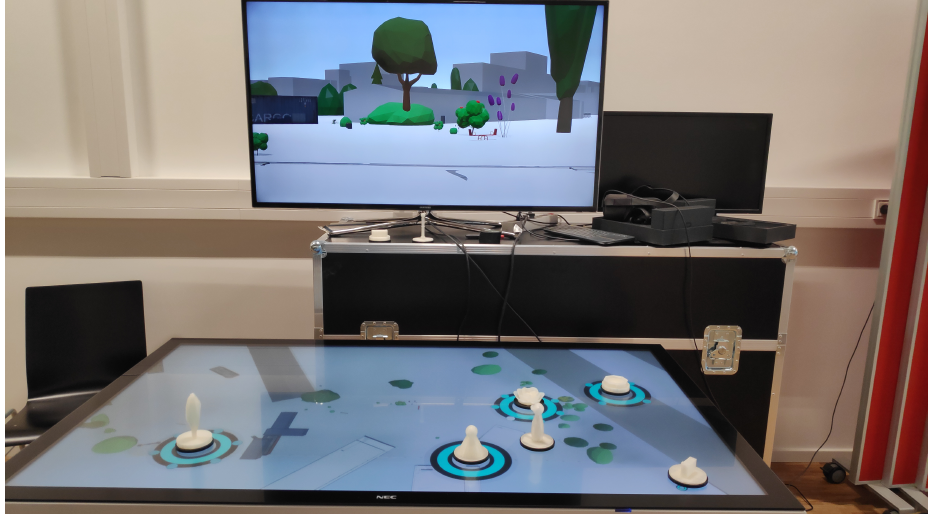
Figure 2. PaKOMM’s touch table setup consists of a horizontal main screen where interactions are performed and a vertical screen where the participants can observe their edits from a different perspective, which can be manipulated on the touch table as